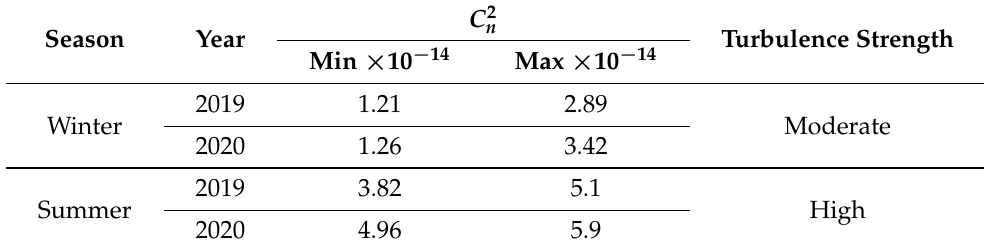
Table 2. Result Calculation of Refractive Index Structure